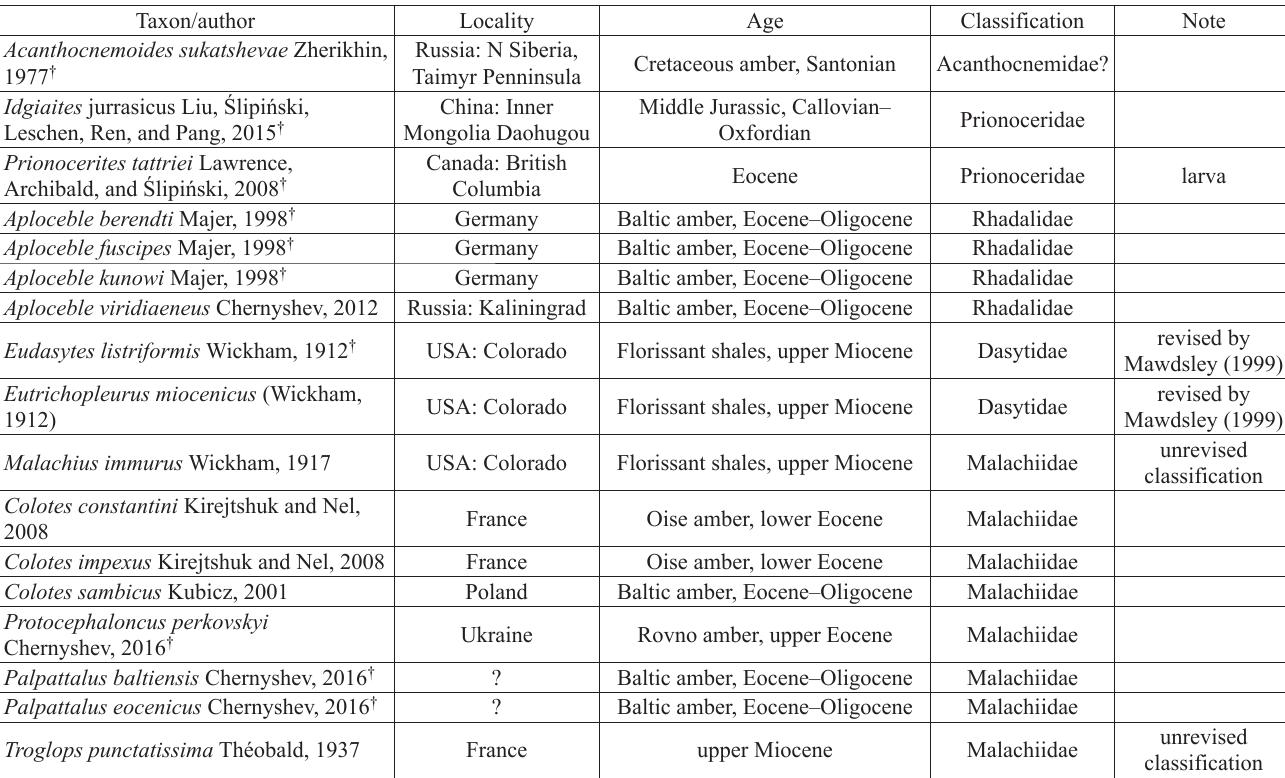
Table 1. List of fossils described within the melyrid lineage of the superfamily Cleroidea. Species within particular families are ordered by age of the deposit († denotes genera containing exclusively fossil